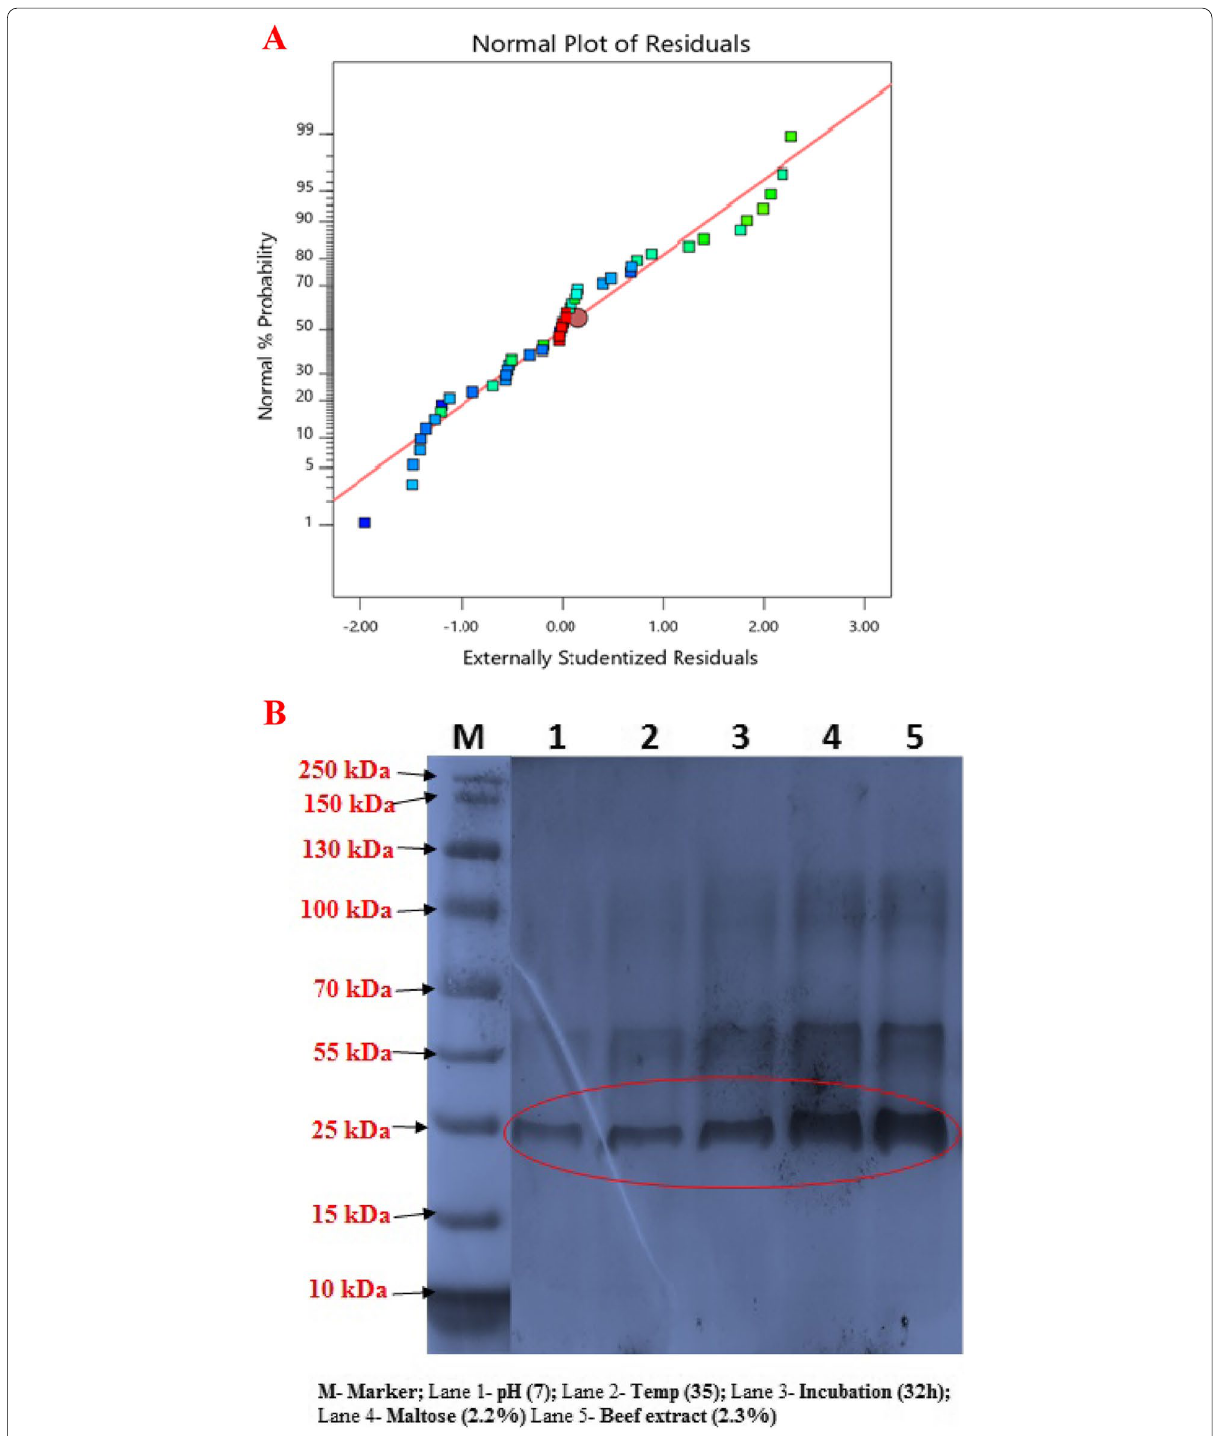
Fig. 4 Normal probability plot of studentized residual ( A ); SDS-PAGE analyses by extracellular proteins ( B